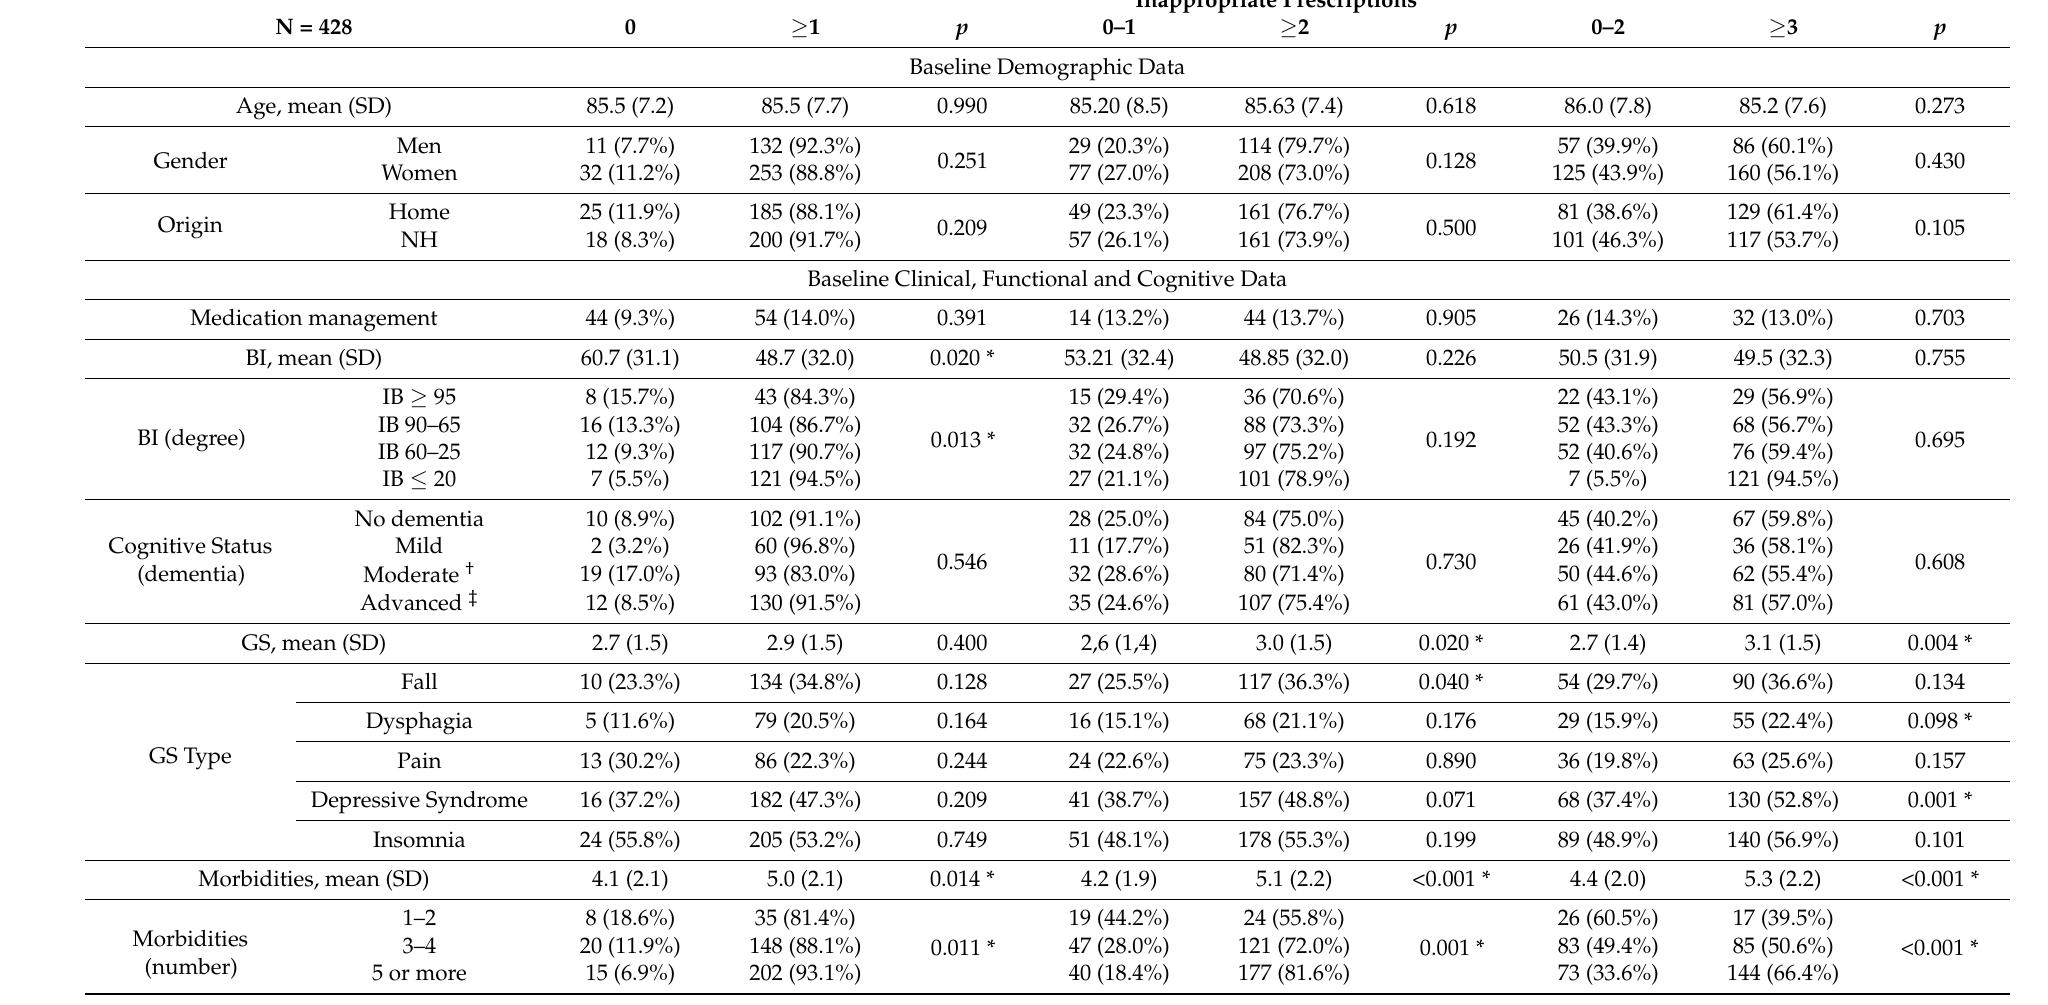
Table 4. Descriptive analysis at baseline and number of Inappropriate Prescriptions (IPs): 0 (n = 43, 10.0%), 0–1 (n = 385, 24.8%), ≥ 2 (n = 322, 75.2%), 0–1 (n = 182, 42.5%), and ≥ 3 (n = 246,